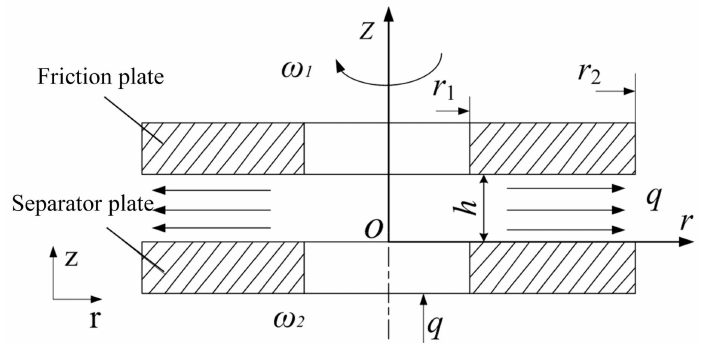
Figure 2. Simplified model for friction pair ( ω 1 is rotation speed of friction plate; ω 2 is rotation speed of separator plate; r 1 is inner radius; r 2 is outer radius; h is oil film thickness; q and nearby arrows are directions of oil